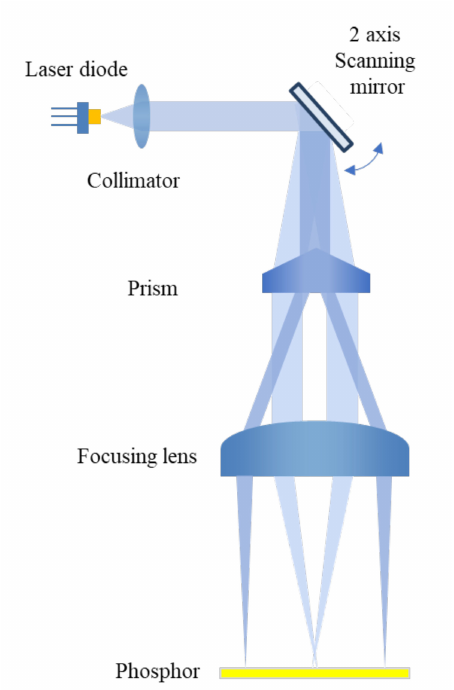
Figure 3. Schematic diagram of proposed optical system for laser diode scanner